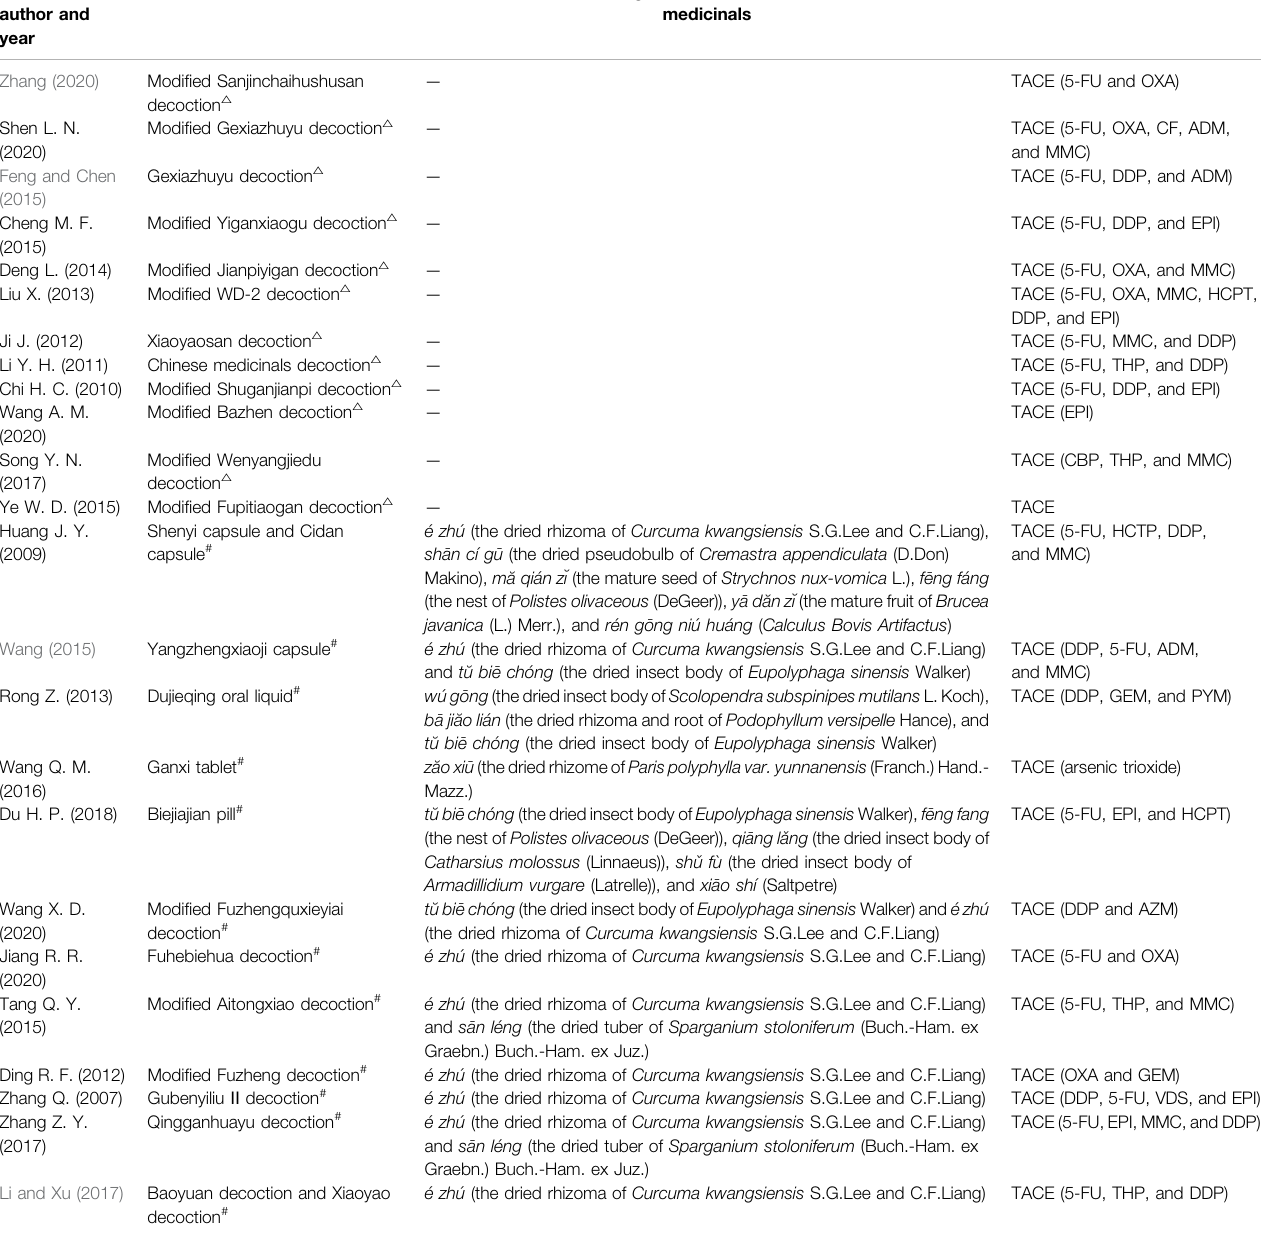
Abbreviations: 5-FU, 5- fl uorouracil; DDP, cisplatin; OXA, oxaliplatin; CBP, carboplatin; CF, calcium folinate; ADM, doxorubicin; EPI, epirubicin; THP, pirarubicin; MMC, mitomycin; AZM, azithromycin; GZM, gemcitabine; PYM, bleomycin A5; HCPT, hydroxycamptothecin; VDS, vindesine sulfate. △ CMFs adopt the therapeutic principles of PSSQ. # CMFs adopt the therapeutic principles of